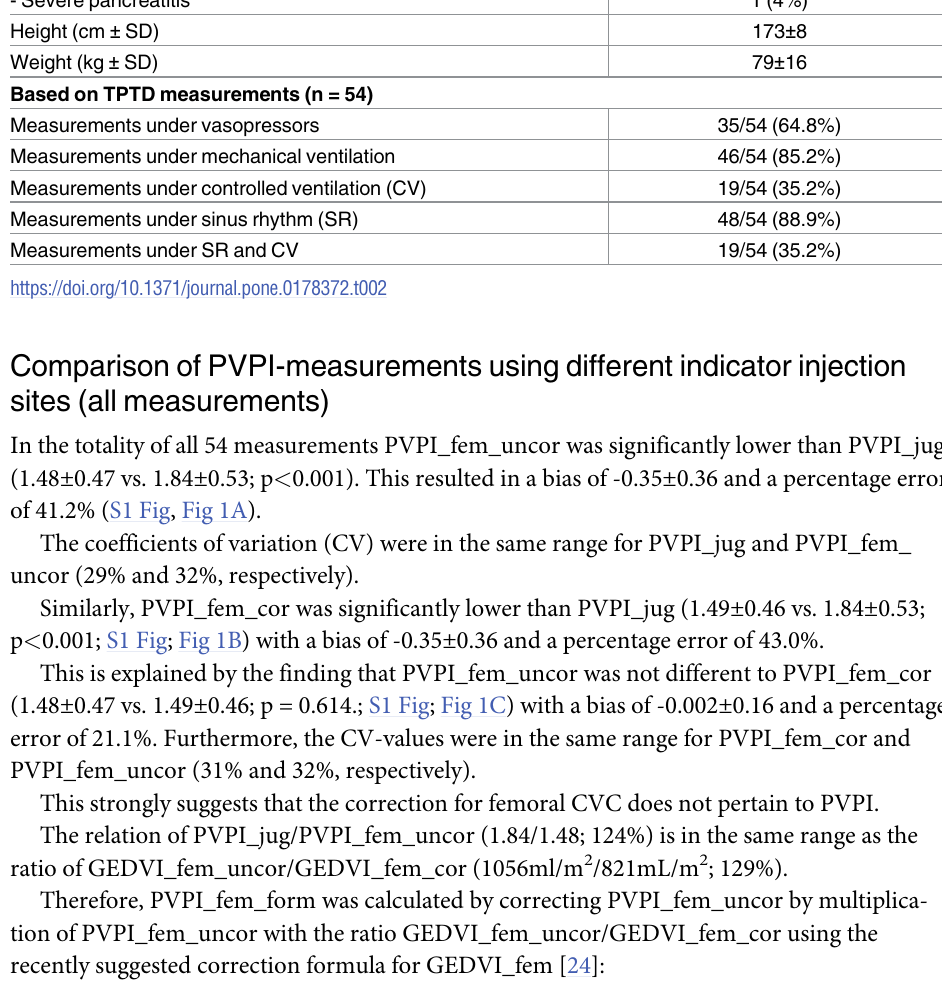
Table 2. Based on individual patients (n =